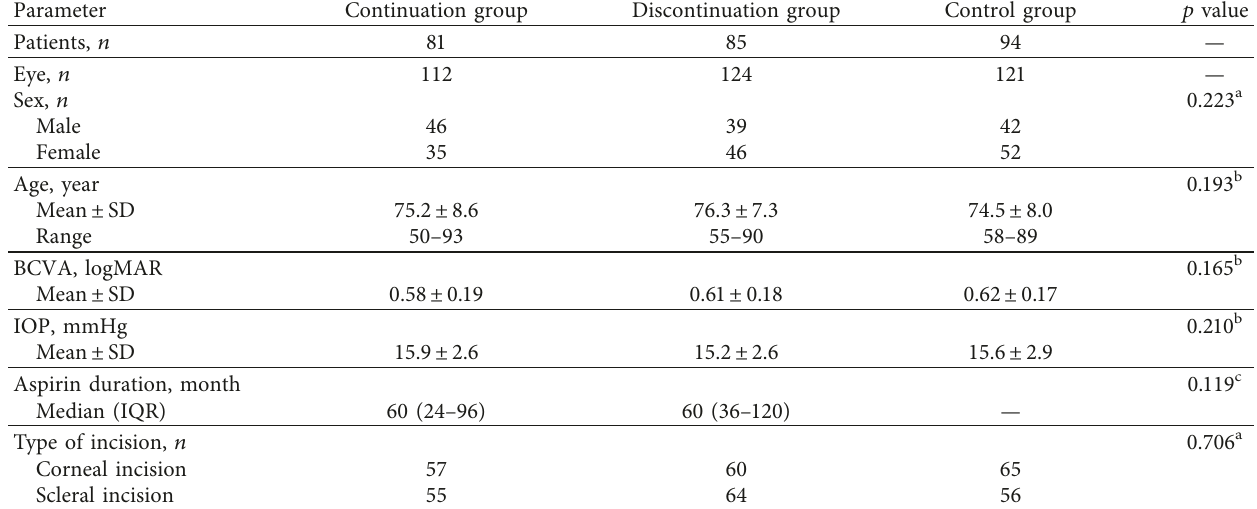
Table 1: Demographic